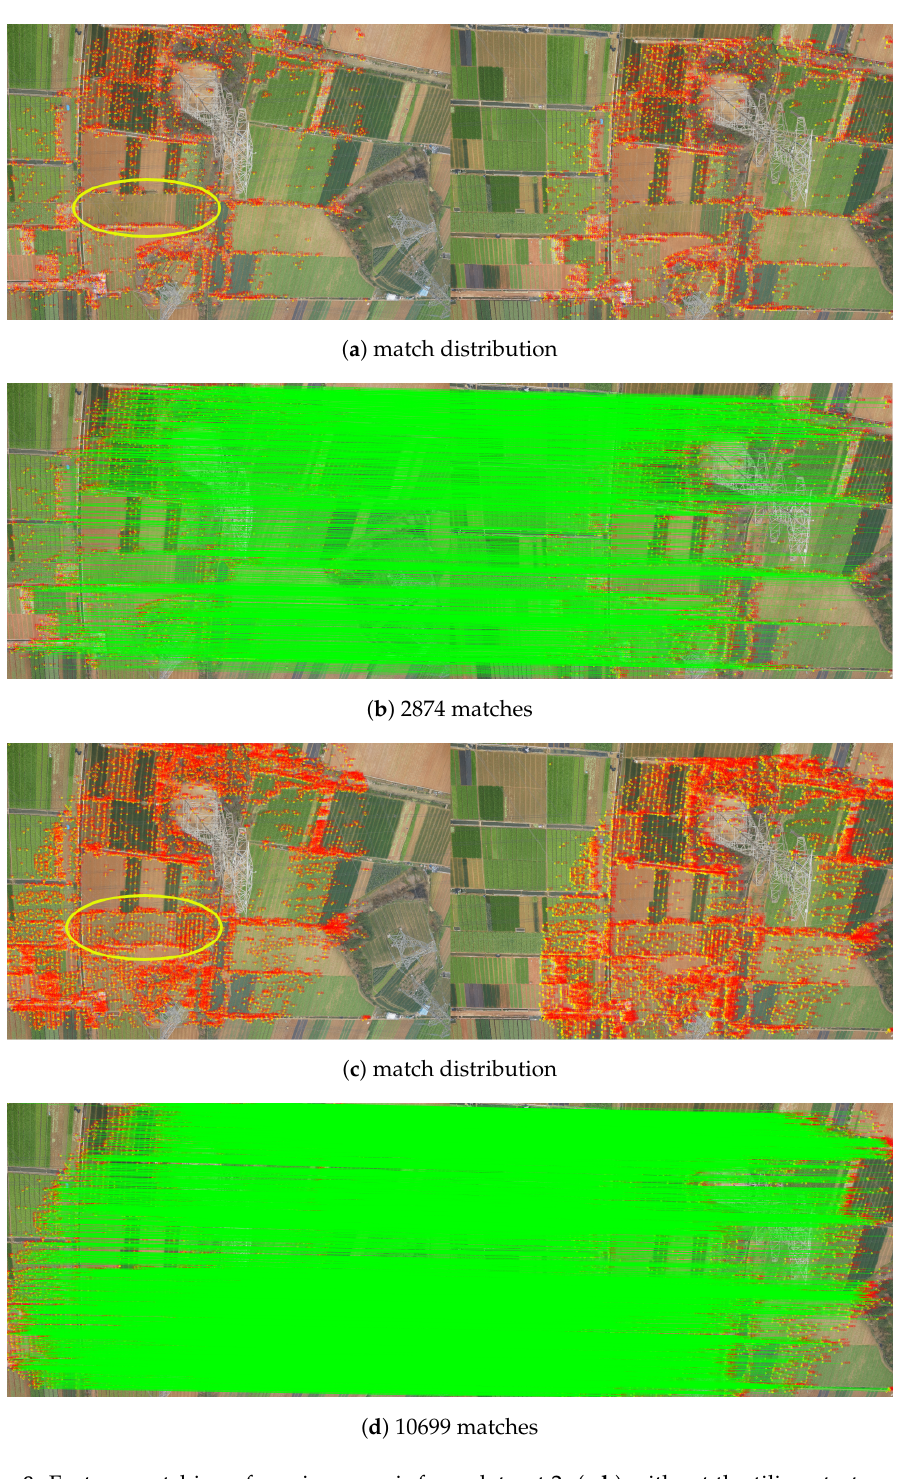
Figure 8. Feature matching of one image pair from dataset 2: ( a , b ) without the tiling strategy; ( c , d ) with the tiling